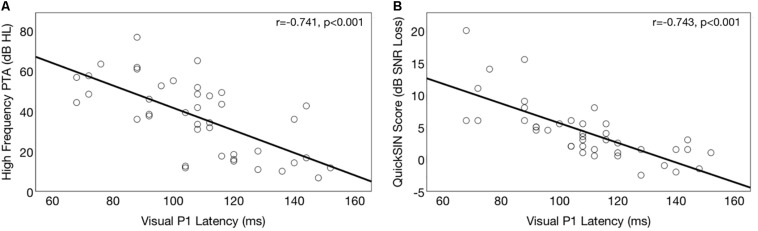
Association between baseline cortical visual evoked potential latencies (CVEP) and auditory function in the hearing loss group. (A) Depicts correlations between right temporal CVEP P1 peak latency (in milliseconds) and high frequency pure tone average (averaged across the right and left ear) in the ARHL group. A higher pure tone average (measured in dB hearing level, or dB HL) indicates more severe hearing loss. Earlier CVEP latency, considered an index of visual cross-modal re-organization, is associated with more extensive auditory deprivation in the high frequencies. (B) Depicts correlations between right temporal CVEP P1 peak latency (in milliseconds) and binaural auditory speech perception in noise (QuickSINTM) performance for the ARHL group at baseline. A higher QuickSINTM score indicates poorer performance in background noise. Earlier CVEP latency, considered an index of visual cross-modal re-organization, is associated with poorer auditory performance in background noise.